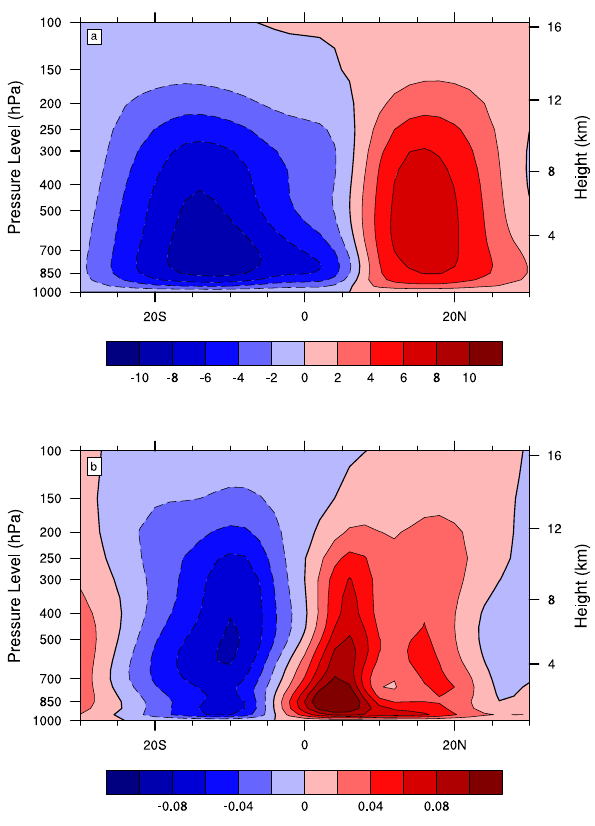
Fig. 4. (a) Climatology ( × 10 10 kgs − 1 ) and (b) trend ( × 10 10 kgs − 1 per decade) of the mass stream function of the Hadley Cir- culation for 1871–2008.